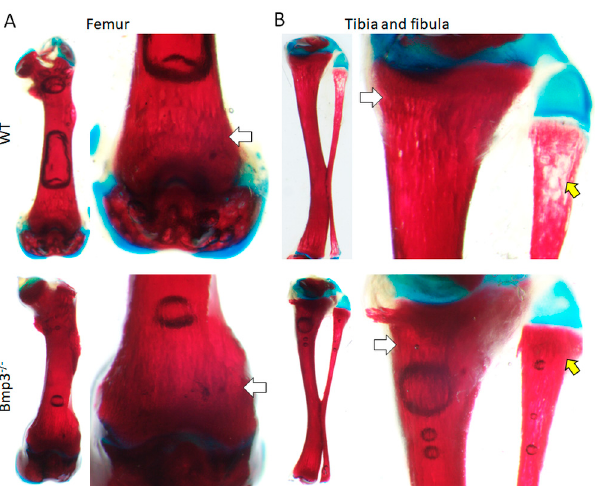
Figure 2. Differential skeletal staining of long bones in P14 mice. Mineral deposition (white arrows) in the distal femur ( A ) and proximal tibia ( B ) appears more pronounced in Bmp3 − / − mice compared to WT mice. The effect is the most pronounced in the proximal fibula (yellow arrow) where observable vesicles were present in all WT mice, but not in any of the analyzed Bmp3 − / − mice. 2.3. Changes in Cortical and Trabecular Long Bone Parameters of Bmp3 − / − Mice Are Not Age- or Sex-Dependent